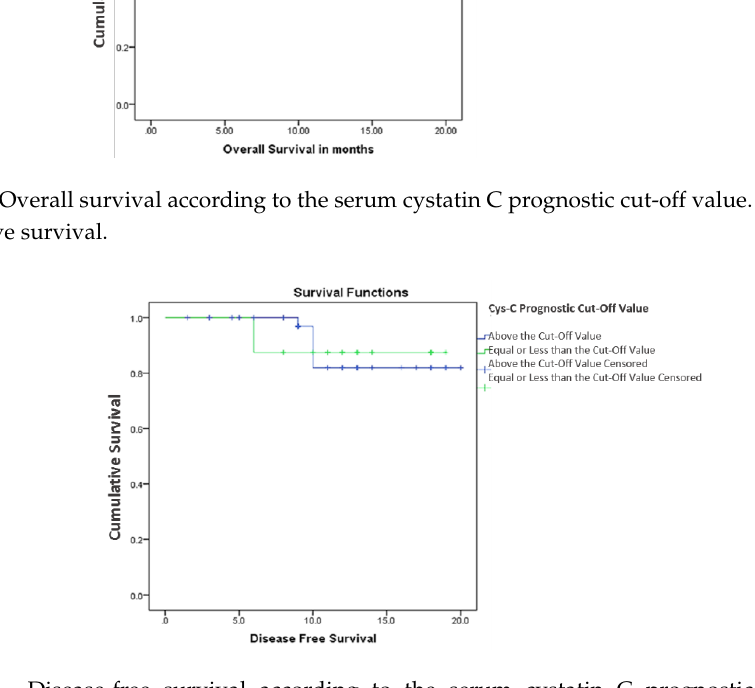
Figure 5. Disease-free survival according to the serum cystatin C prognostic cut-off value. Cum Survival: cumulative survival.